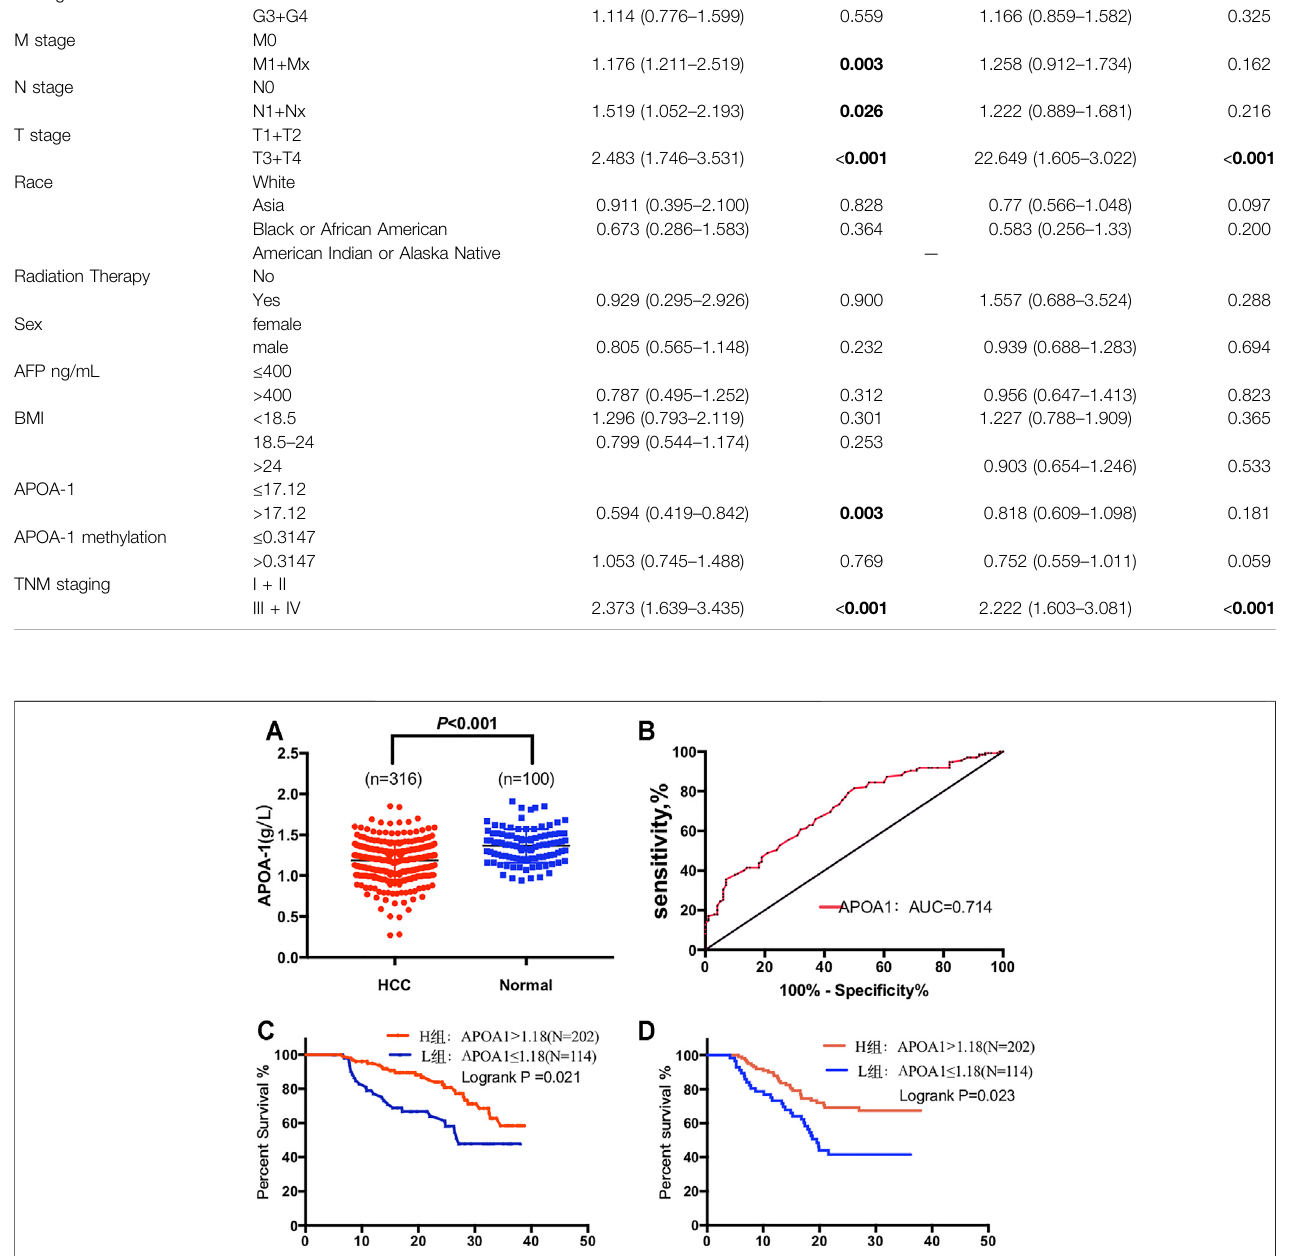
Frontiers in Genetics |